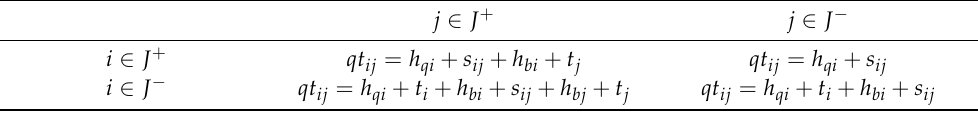
Table 1. Time interval between AGV arriving at adjacent